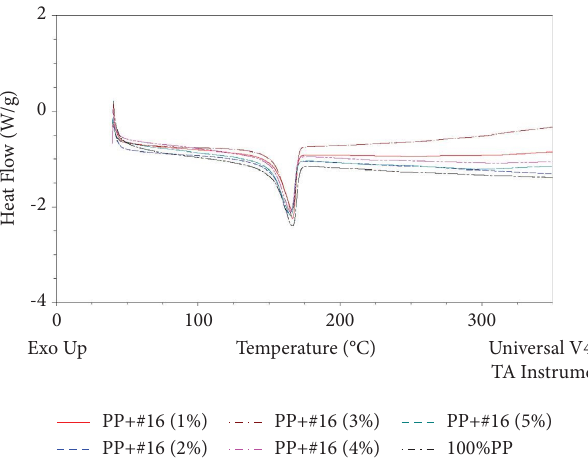
Figure 4: DSC graphs of pure PP and #16 samples. Table 3: Calorimetric parameters and the degree of crystallinity of PP and #16 samples.